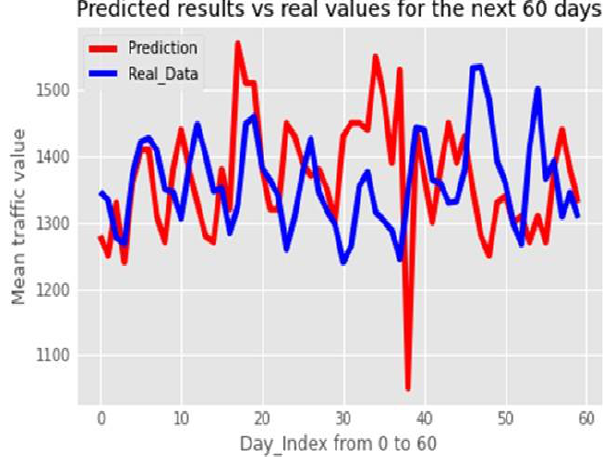
Figure 6. Prediction of mean traffic for learning rate LR=0.0025 and β =0.99.